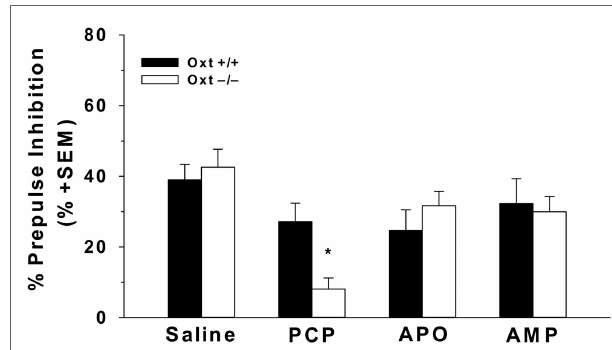
FiguRe 3 | Oxt − / − mice have greater PCP-induced deficits in sensorimotor gating . The acoustic startle of male Oxt + / + ( n = 12) and Oxt − / − mice ( n = 8) was measured using the whole body reflex flinch in reaction to a startle tone using startle chambers (SR-LAB; San Diego Instruments, San Diego, CA, USA). Mice were administered either an i.p. injection of 10 mg/kg AMP and APO, a subcutaneous injection 6 mg/kg PCP, or an equivalent volume of 0.9% saline as a control 15 min prior to testing. Testing session consisted of 60 trials, including no stimulus trials, pulse-alone trials, and prepulse + pulse trials. The testing sessions began and ended with the presentation of five 120 db pulse-alone tones. The middle 50 trials consisted of: 10 no pulse tones trials, 30 prepulse + pulse trials at 3, 6, and 12 db above background, and 10 pulse-alone tones at 120 db. A repeated measures design was used with each animal receiving 0.9% saline, AMP, APO, and PCP, with a minimum of 3 days between each trial. Oxt − / − mice display greater reductions in the average percent PPI across three prepulse levels (3, 6, and 12 db above background) following an injection of PCP compared to Oxt + / + mice. There were no genotypic differences in PPI following injection of AMP or APO. Adapted and reprinted with permission from Macmillan Publishers Ltd: Molecular Psychiatry, Caldwell et al.